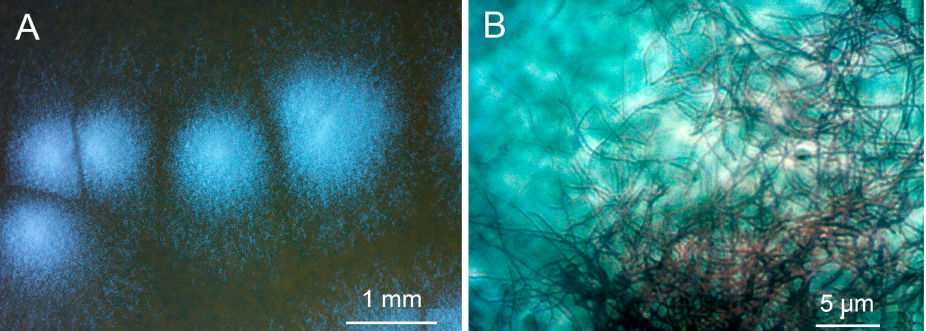
Figure 1. Appearance of the colonies ( A ) and mycelium ( B ) of the strain Streptomyces sp. P-56.